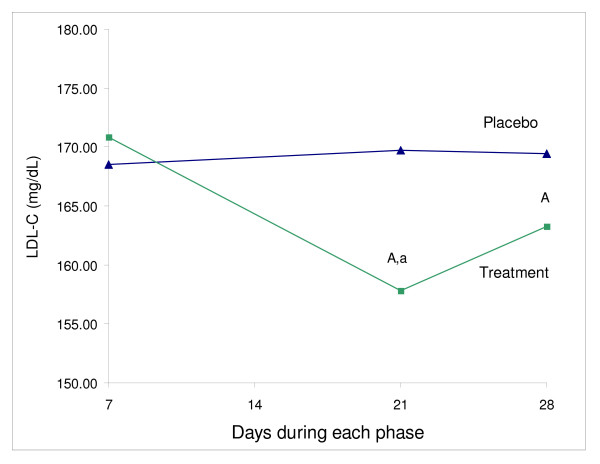
The effect of plant sterol ester on LDL – cholesterol (mg/dL) (N = 16). A Significantly different from placebo, p < 0.05 (paired t-test) a Significantly different within phase, p < 0.05 (1-way repeated measure ANOVA)